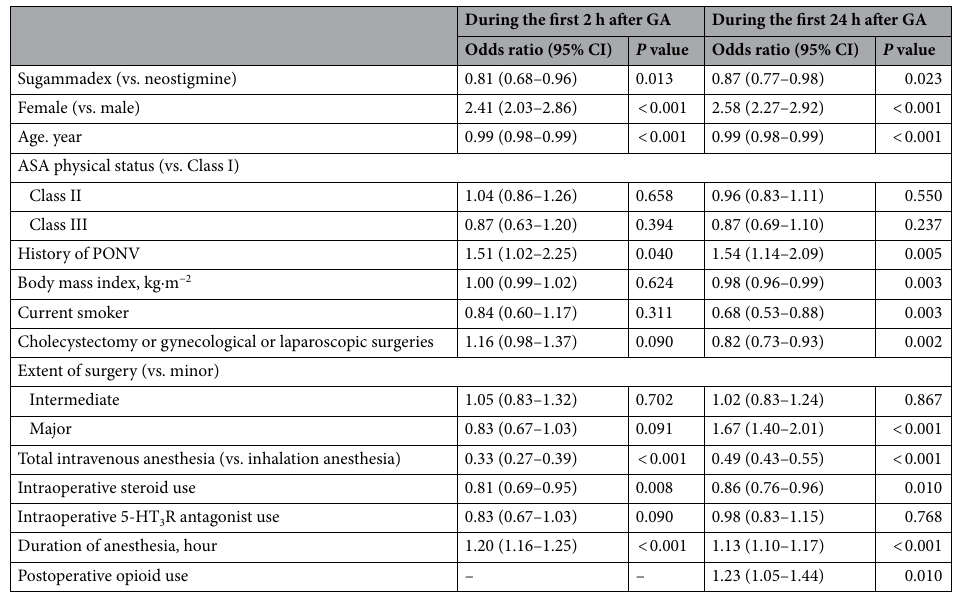
Table 4. Predictive factors associated with postoperative nausea and vomiting during the first and 24 h after general anesthesia (GA) based on binary multivariable logistic regression analyses. CI Confidence interval, ASA American society of anesthesiologists, PONV Postoperative nausea and vomiting, 5-HT 3 R, 5-hydroxytryptamine